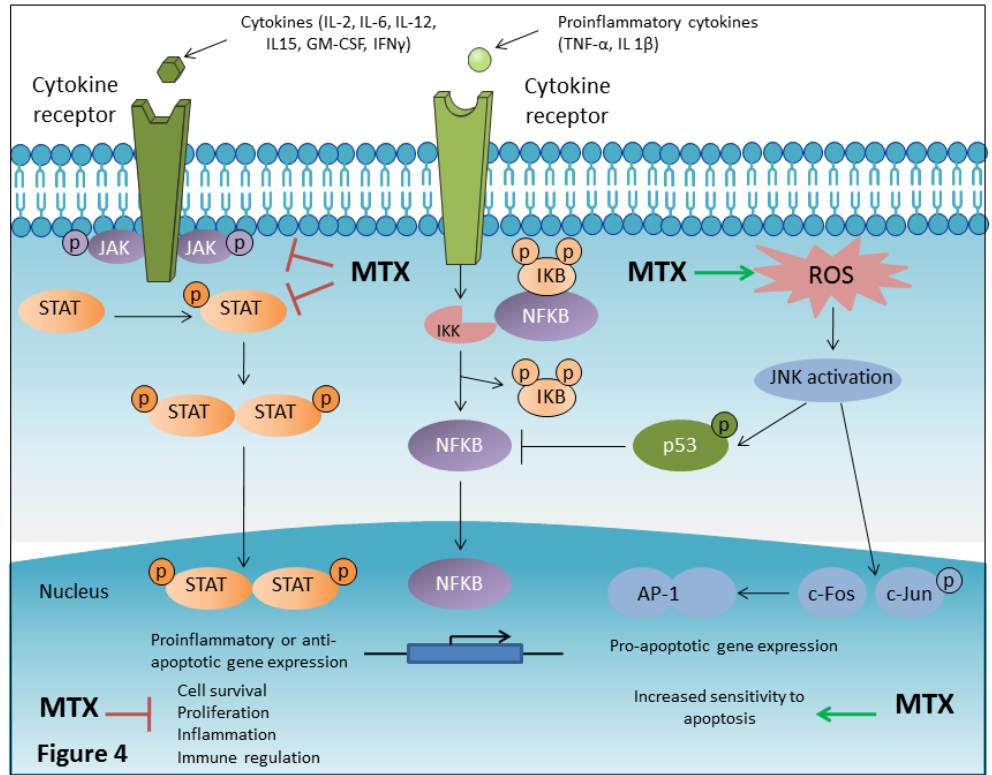
Figure 4. MTX affects several signal transduction pathways implicated in the pathogenesis of rheumatoid arthritis (RA). Dysfunctional intracellular signaling involving deregulated activation of the Janus Kinase / Signal Transducers and Activators of Transcription (JAK / STAT) and nuclear factor- κ B (NF- κ B) activation pathways play a critical role in RA. MTX seems to be a potent suppressor of JAK / STAT signaling pathway which is responsible for the transduction of multiple pro-inflammatory cytokines implicated in the pathogenesis of RA. MTX reduces JAK1, JAK2, STAT1, and STAT5 phosphorylation. Low dose MTX strongly suppresses levels of phosphorylated STAT5. Moreover, MTX-mediated ROS production activates the mitogen-activated protein kinase (MAPK), Jun-N-terminal kinase (JNK), and JNK-dependent induction of p53, which is the final mediator of inhibition of NF- κ B activation. NF- κ Bisinvolvedininflammation, immuneresponseandcellproliferationandsurvival. MTX-mediated JNK activation also activates prototypical JNK downstream targets, c-JUN and c-FOS, components of the AP-1 complex which is involved in the increased expression of pro apoptotic genes (such as TNF- α , Fas-L, and Bak) mediating increased sensitivity of cells to